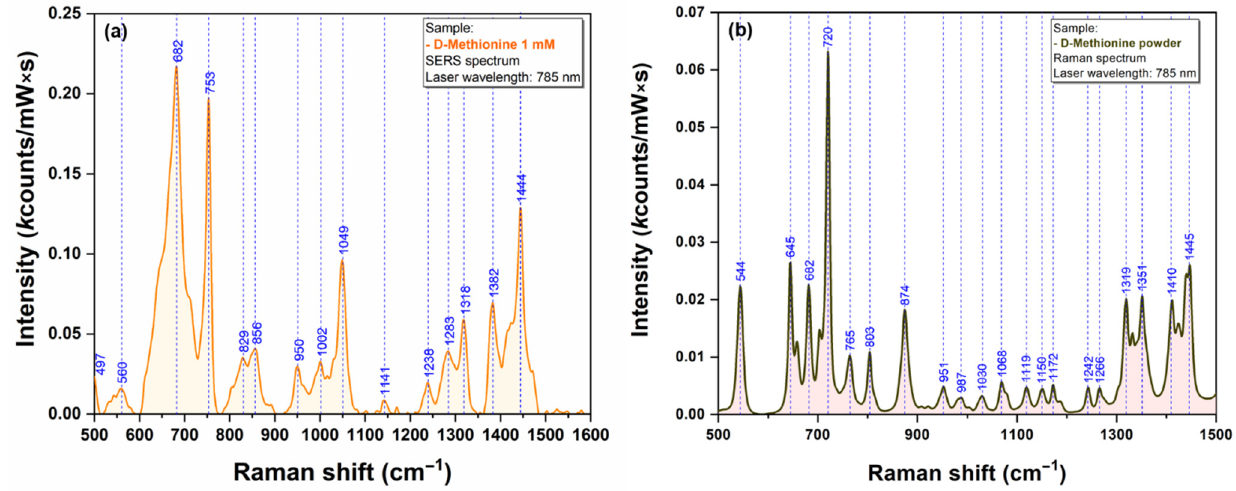
Figure 13. SERS ( a ) and Raman ( b ) spectra of Methionine (1 mM) ( a ) recorded using a 785 nm excitation laser.